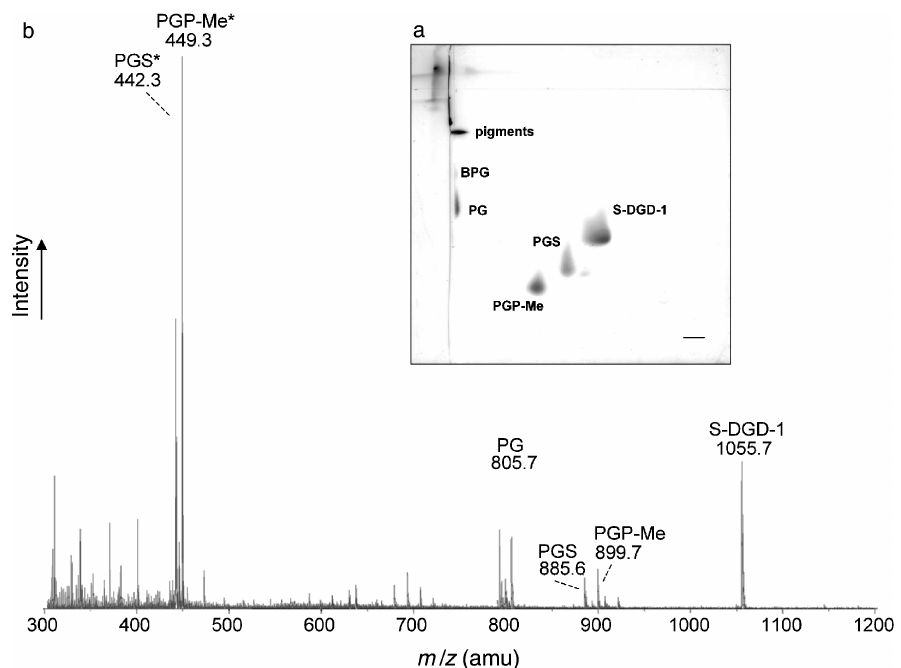
volcanii (see Figure 3).